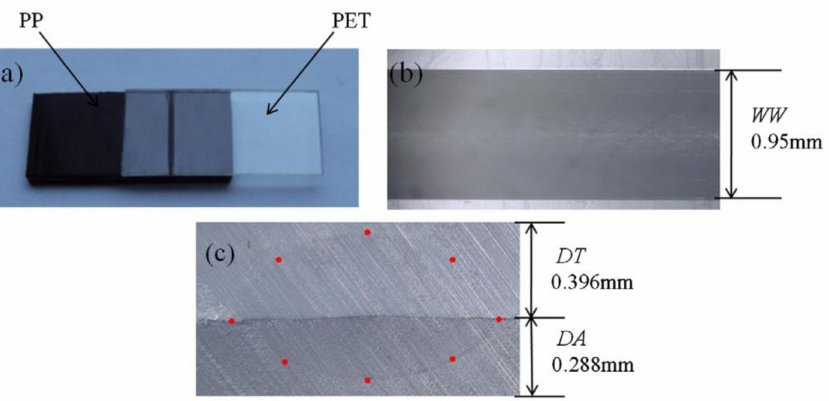
Figure 17. Various images of the weld ( a ) macroscopic welding sample, ( b ) micrograph of the weld width and ( c ) micrograph of the molten pool [183]. Reproduced with permission from Ref. [183]. Copyright (2014), Materials and